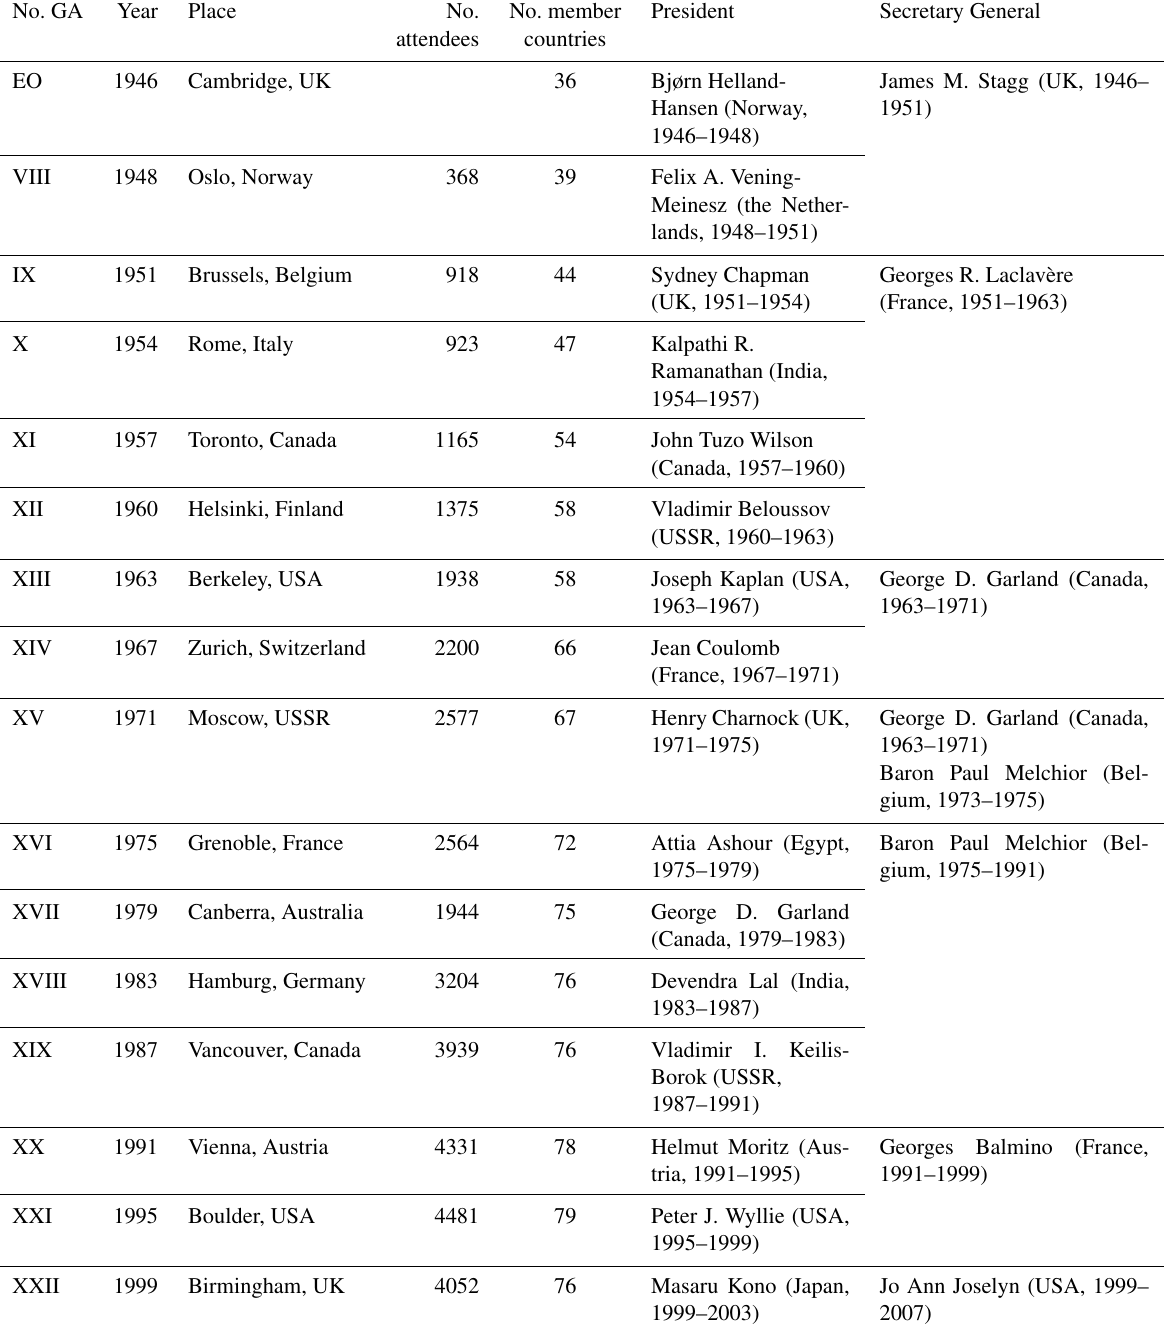
Table A1. IUGG General Assemblies from 1946 to 1999, and IUGG Presidents and Secretaries General